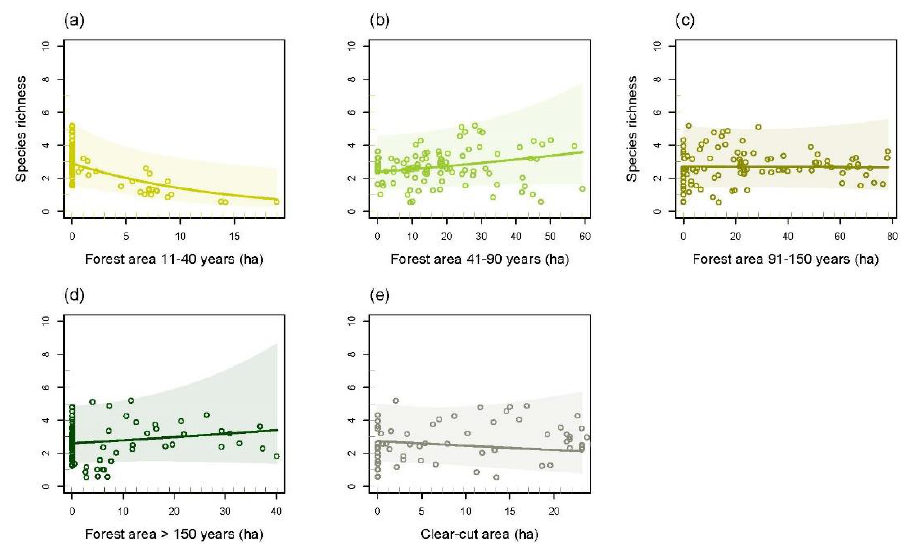
Figure 8. Visualizations of GLMM results revealing the relationships (solid line) between the forest age (in hectares) and species richness at the mist-netting site level (dots): ( a ) Forest area 11–40 years, ( b ) Forest area 41–90 years, ( c ) Forest area 91–150 years, ( d ) Forest area older than 150 years, ( e ) Clear- cut area.